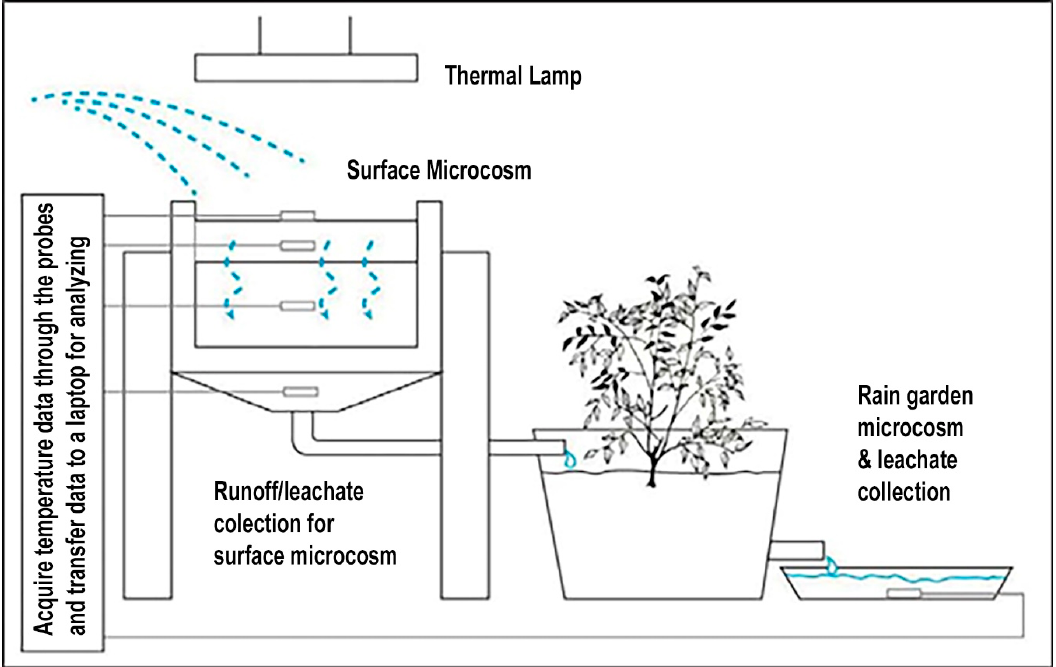
Figure 4. Substrate runoff/leachate funneled into adjacent rain garden microcosms [54].